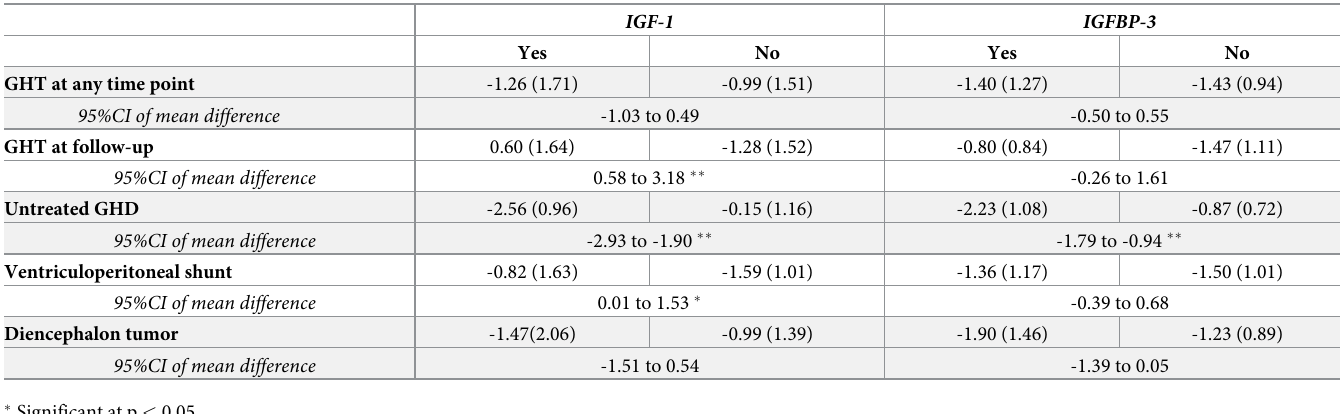
Table 3. Mean (SD) IGF-1 and IGFBP-3 Z-scores of 72 subjects at